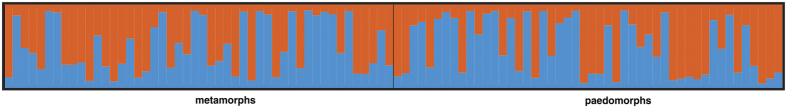
Bayesian population assignment test of paedomorphic and metamorphic palmate newts (Larzac, France).Each vertical bar in the Y-axis represents an individual, and the color composition displays the probability to belong to one of the clusters defined by STRUCTURE (CLUMPAK plot). The black vertical line delineates the pre-defined populations.